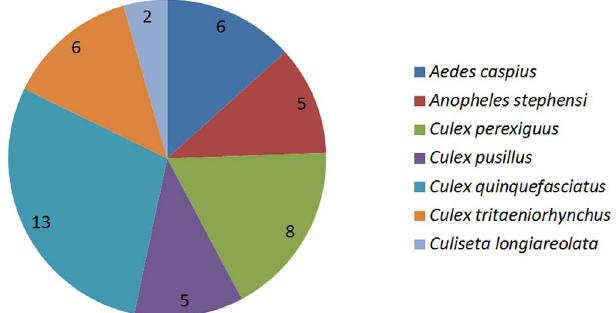
Figure 3. Numbers of positive sites for every mosquito species observed during our fi eld surveys in Qatar, September 2017 and January 2019, by any sampling method, for a total number of 20 sites.